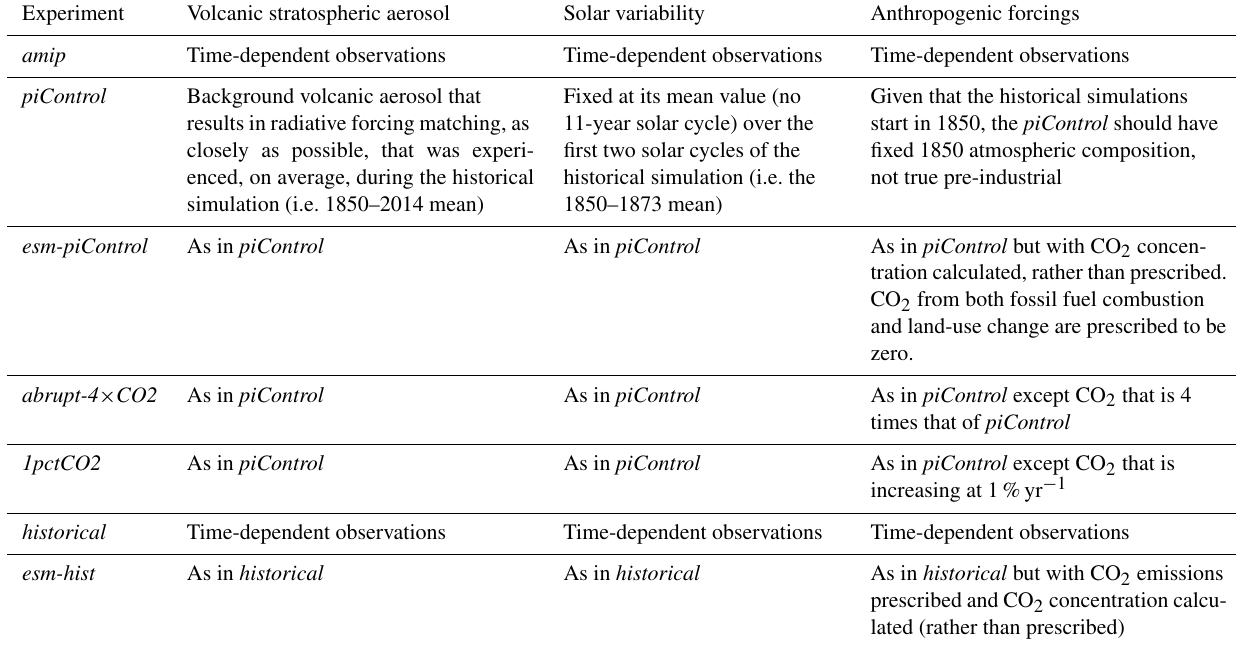
Table A1. Specifications in the DECK and CMIP6 historical simulations.